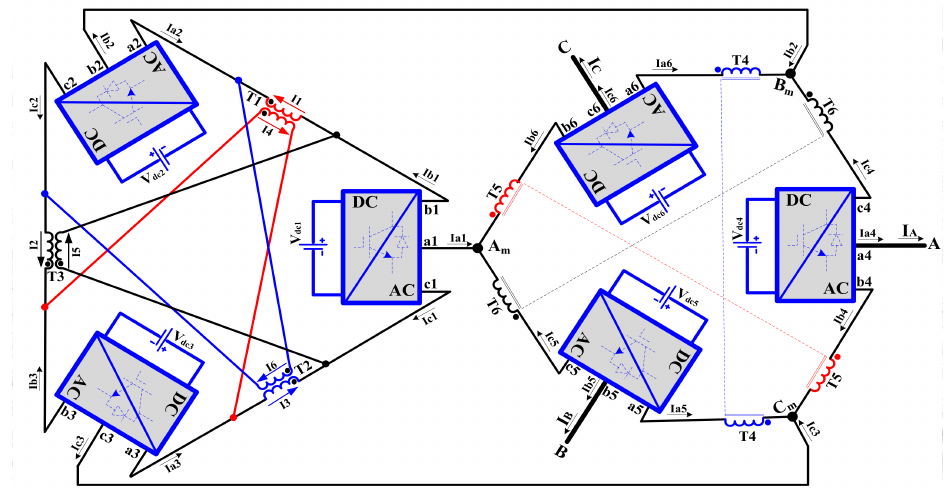
Figure 2. Proposed multilevel Voltage Source Converter (VSC)